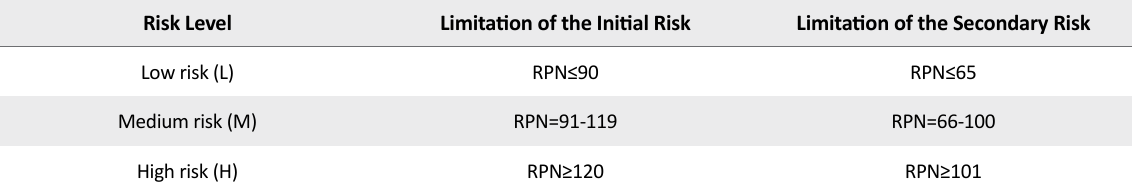
Table 6. Determining the approximate level of risk in FMEA Risk